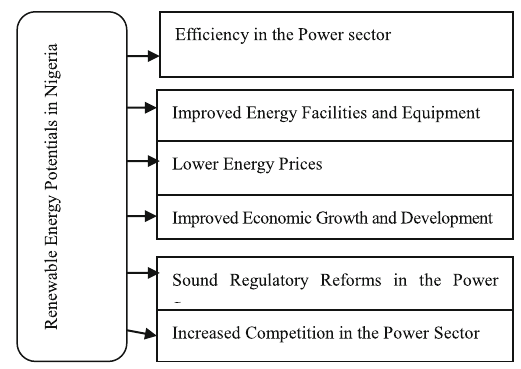
Fig. 2 Advantages of Renewable Energy in Nigeria